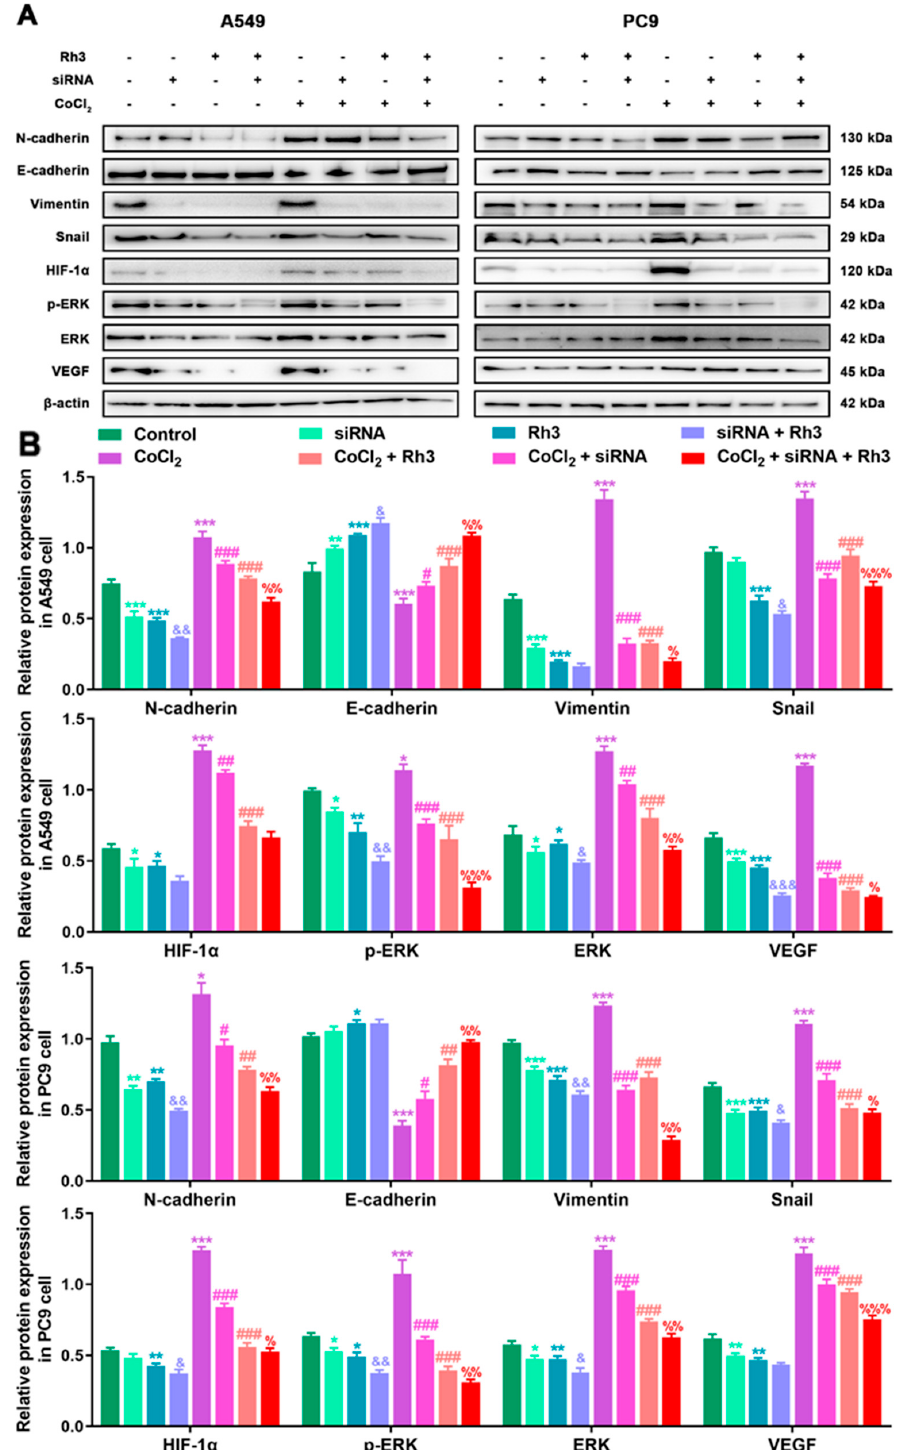
Figure 9. ERK-siRNA enhances Rh3 action in relation to the EMT process and the ERK pathway in A549 and PC9 cells. ( A ) HIF-1 α , ERK, p-ERK, VEGF, and EMT-related protein expression in A549 and PC9 cells following treatment with 40 µ M Rh3, siRNA, and 100 µ M CoCl 2 . ( B ) Protein expression is represented by the histograms. * p < 0.05, ** p < 0.01, *** p < 0.001 compared with the control group; # p < 0.05, ## p < 0.01, ### p < 0.001 compared with the CoCl 2 group; & p < 0.05, && p < 0.01, &&& p < 0.001 compared with the Rh3 group; % p < 0.05, %% p < 0.01, %%% p < 0.001 compared with the CoCl 2 + Rh3